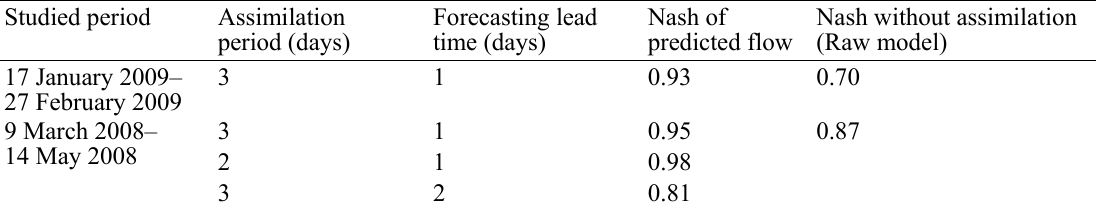
Table 2 Performance of forecasting with different combinations of assimilation windows and forecast lead times, for the Serein. Studied